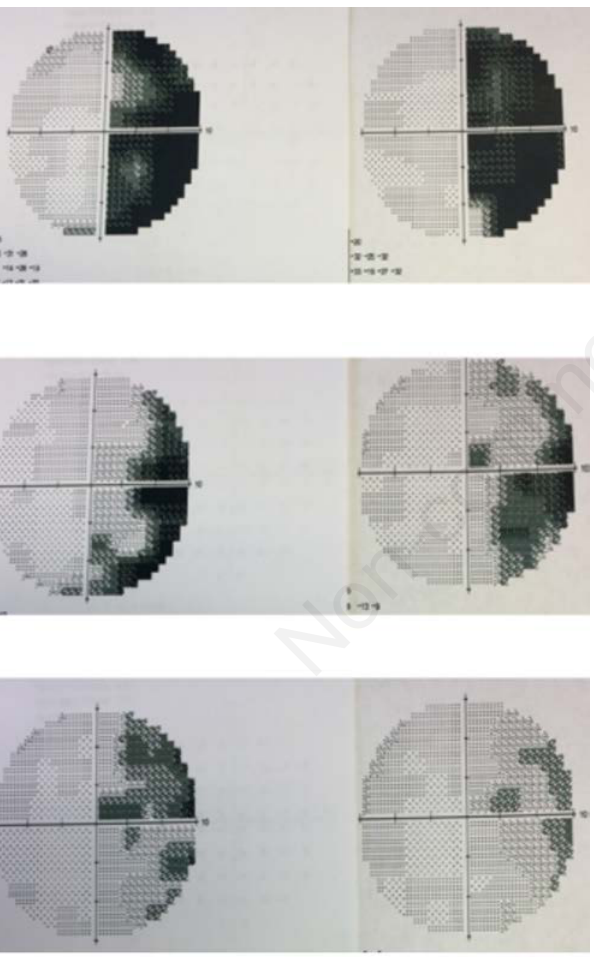
Figure 1. Visual field plots for the left eye (right hand column) and right eye (left hand column) for the baseline exam one year ago (bottom row), 6 months prior (middle row), and current exam taken 12 months after the baseline study, all confirming a progressive encroachment upon the right hemi-field, consistent with an evolving right homonymous hemianopsia over one year.